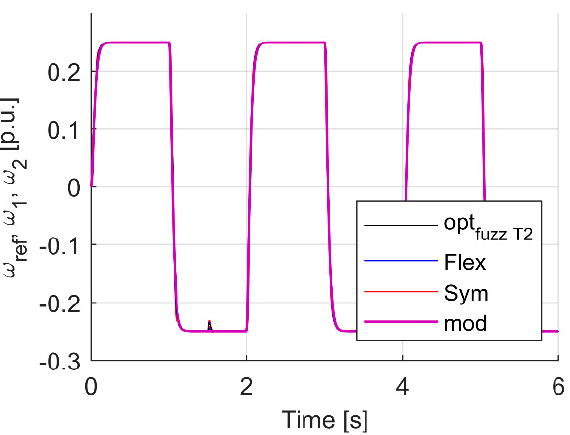
Figure 16. Transients of motor, load and reference speed for analyzed controller cases.